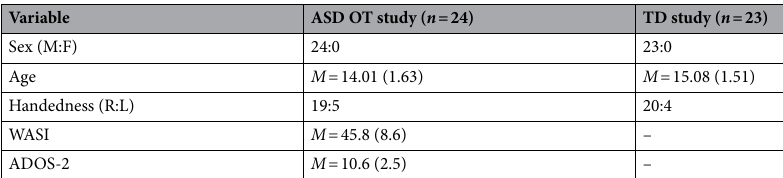
Table 1. Participant characteristics. Note: WASI- Wechsler Intelligence Scale show subtest standardized T-score ( M = 50, SD = 10), ADOS-2—Autism Diagnostic Observation Scale 2nd edition comparison score. No clinical or intellectual assessment was conducted in the TD